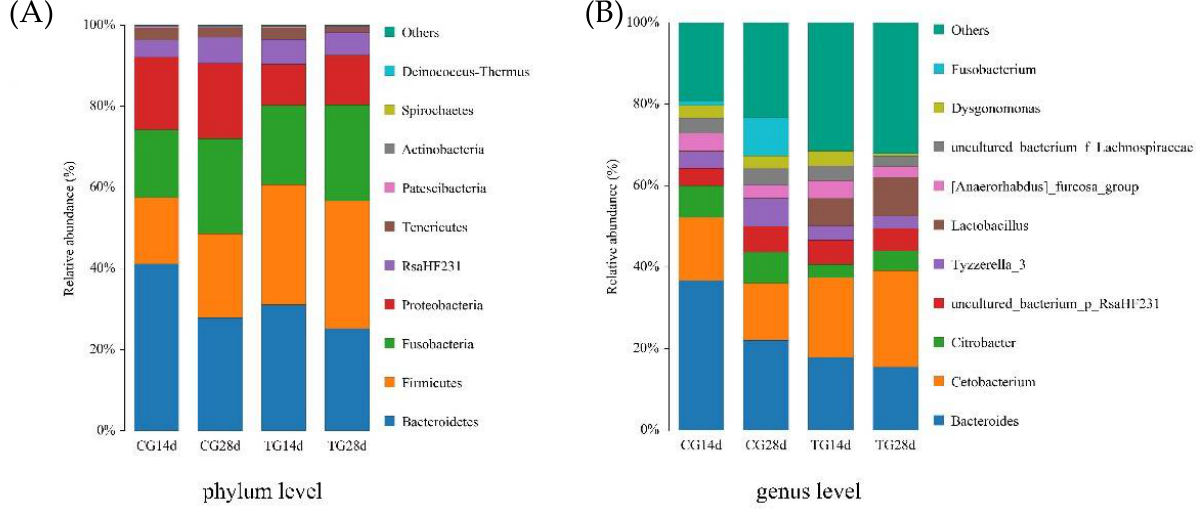
Figure 3. Relative abundance of the intestinal microbiota of crayfish at the phylum ( A ) and genus ( B ) levels. CG14d, control group after 14 days of feeding; CG28d, control group after 28 days of feeding; TG14d, treatment group ( S. cerevisiae at 10 7 CFU/g diet) after 14 days of feeding; TG28d, treatment group ( S. cerevisiae at 10 7 CFU/g diet) after 28 days of